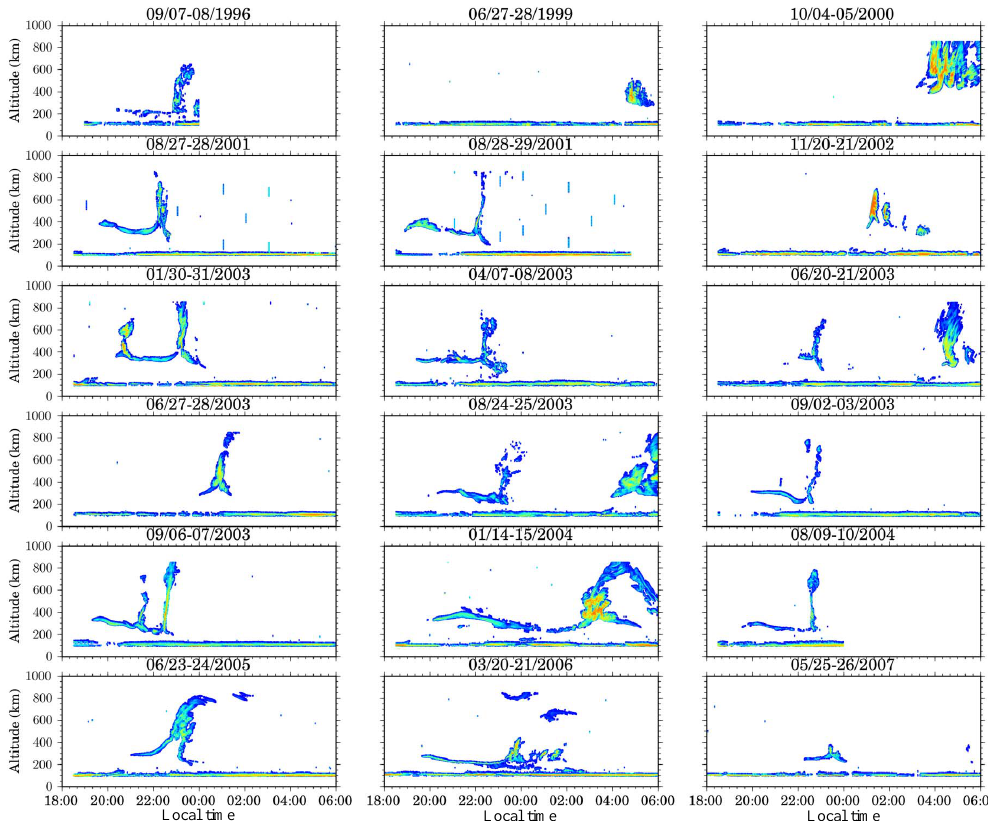
Figure 5. Eighteen range–time–intensity plots of spread-F events. Using the JULIA radar, these are similar-looking events.